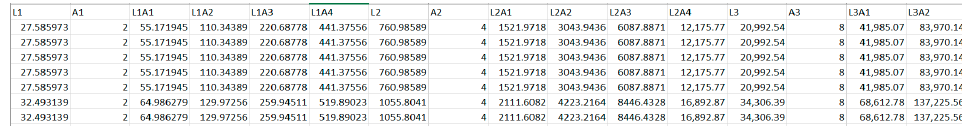
Figure 4. Prepared data set containing powers and interactions of location (manifest norm score) and age.